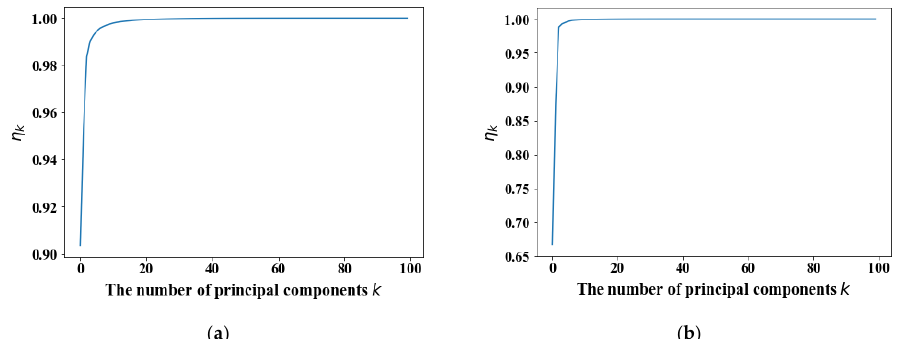
the principal components of the PS1 and PS2 training set samples and the number of principal components is further plotted, as shown in Figure 4.